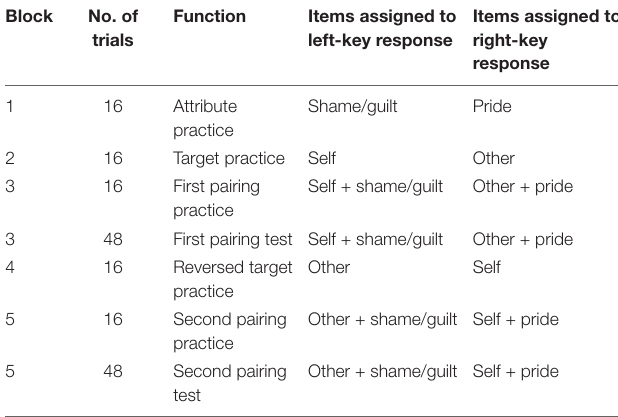
TABLE 1 | Structure of the Implicit Association Test